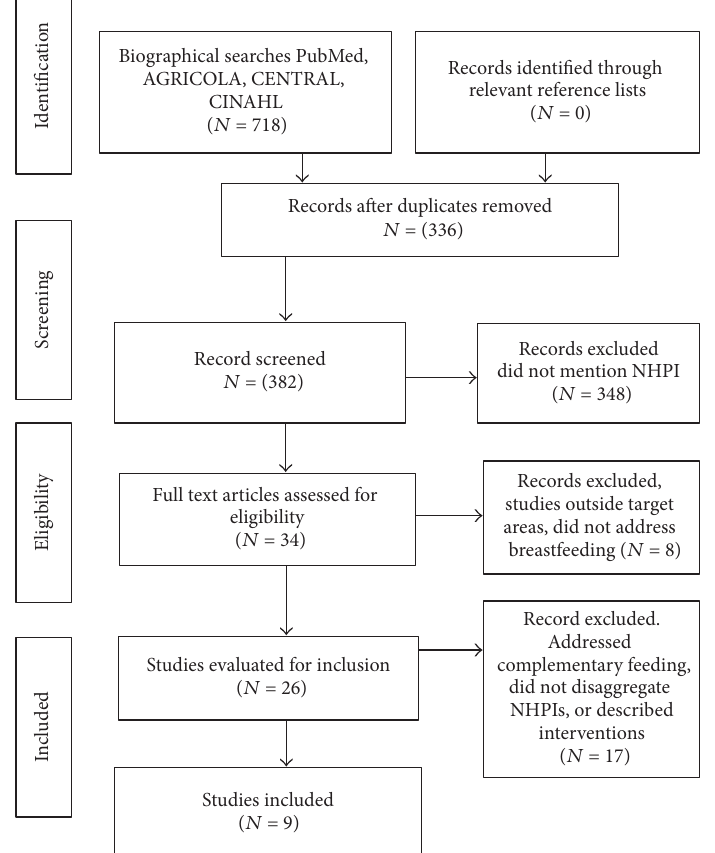
Figure 1: Prisma flow diagram of selected